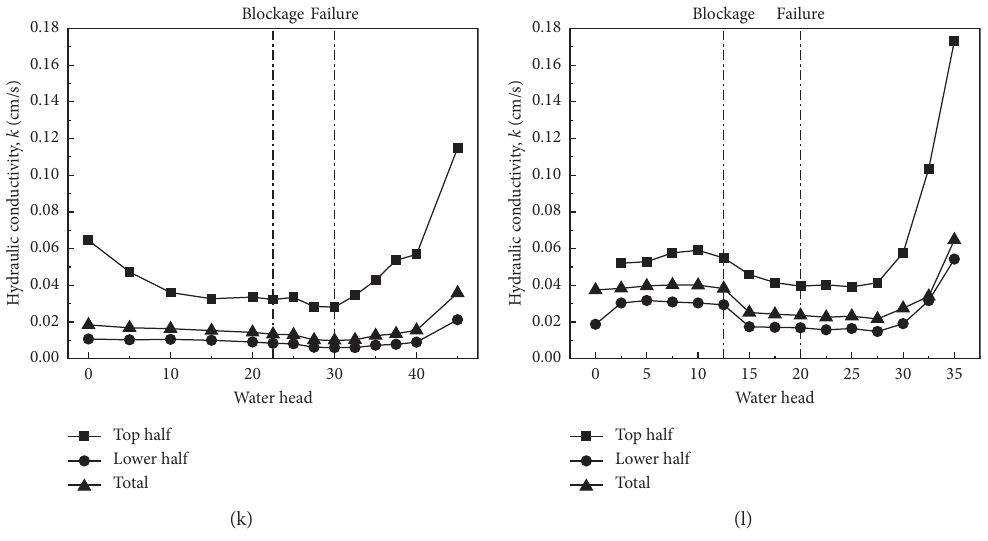
Figure 8: Variation of hydraulic gradient and hydraulic conductivity with water head for FC and CFC groups. (a) Variation of hydraulic gradient of FC-1 with water head. (b) Variation of hydraulic gradient of CFC-1 with water head. (c) Variation of hydraulic conductivity of FC-1 with water head. (d) Variation of hydraulic conductivity of CFC-1 with water head. (e) Variation of hydraulic gradient of FC-2 with water head. (f) Variation of hydraulic gradient of CFC-2 with water head. (g) Variation of hydraulic conductivity of FC-2 with water head. (h) Variation of hydraulic conductivity of CFC-2 with water head. (i) Variation of hydraulic gradient of FC-3 with water head. (j) Variation of hydraulic gradient of CFC-3 with water head. (k) Variation of hydraulic conductivity of FC-3 with water head. (l) Variation of hydraulic conductivity of CFC-3 with water